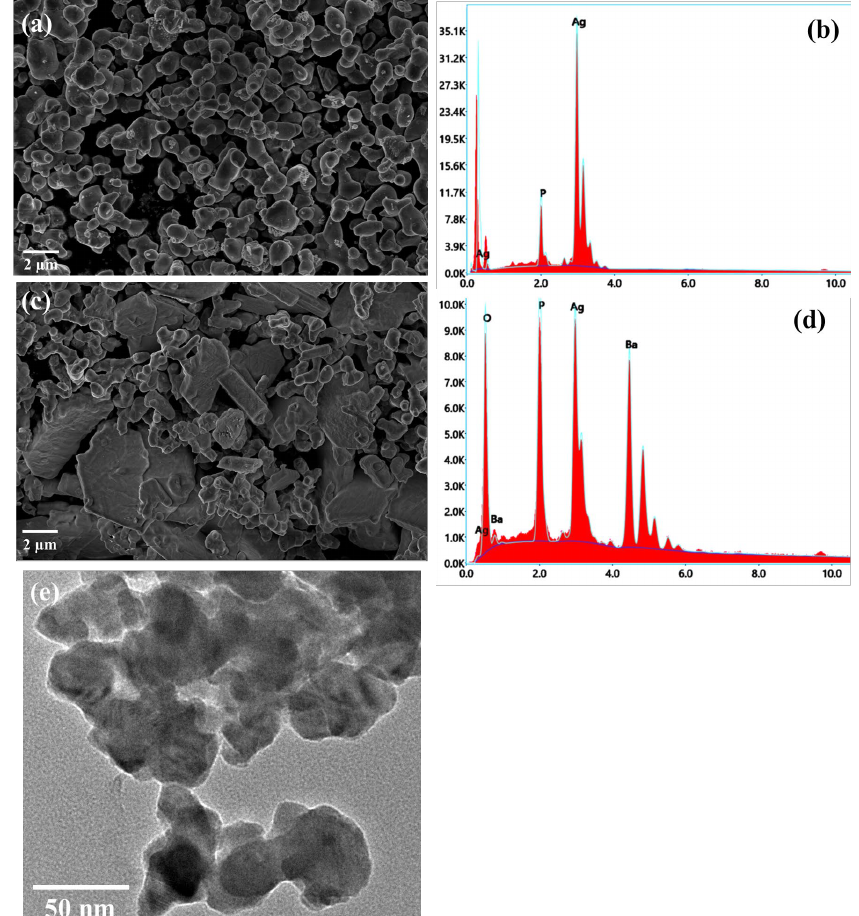
Figure 1. ( a ) Top-view SEM image of Ag 3 PO 4 sample and ( b ) its EDX spectroscopy; ( c ) SEM image of BaO@Ag 3 PO 4 composite and ( d ) its EDX spectroscopy; and ( e ) TEM image of BaO@Ag 3 PO 4 com-